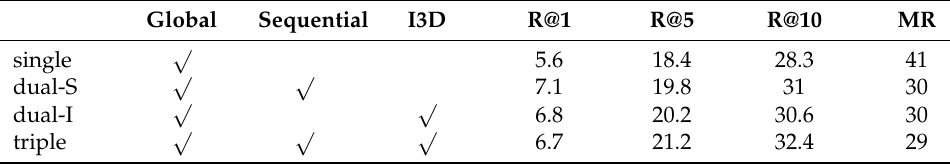
Table 2. Evaluation on combinations of embedding spaces.